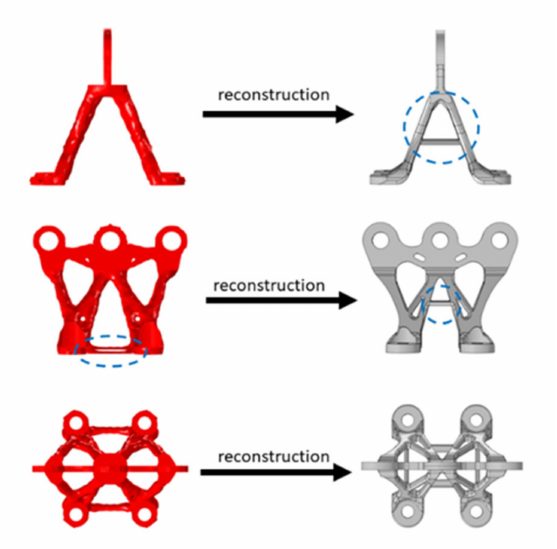
Figure 10. ( a ) Isometric view after reconstruction; ( b ) front view after reconstruction; ( c ) side view after reconstruction; ( d ) top view after reconstruction.